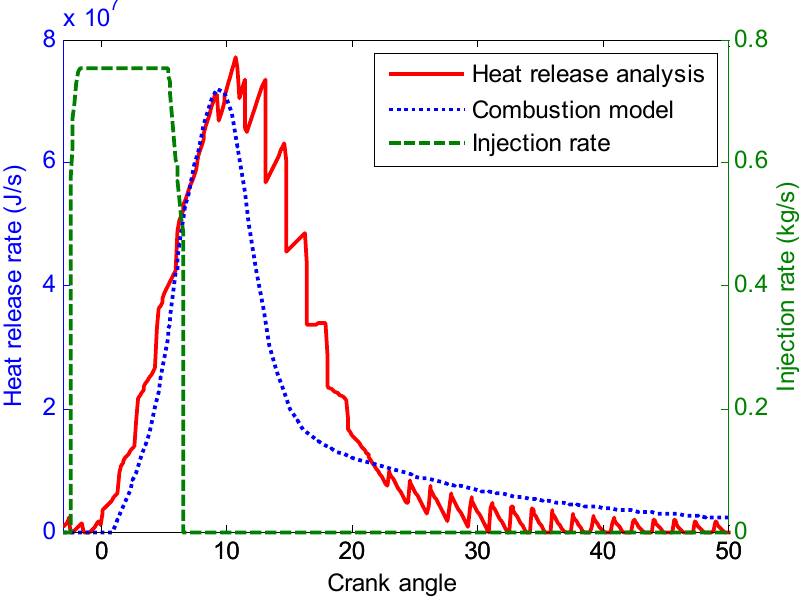
Figure 12. Heat release rate of case 1. Energies 2019 , 12 , x FOR PEER REVIEW